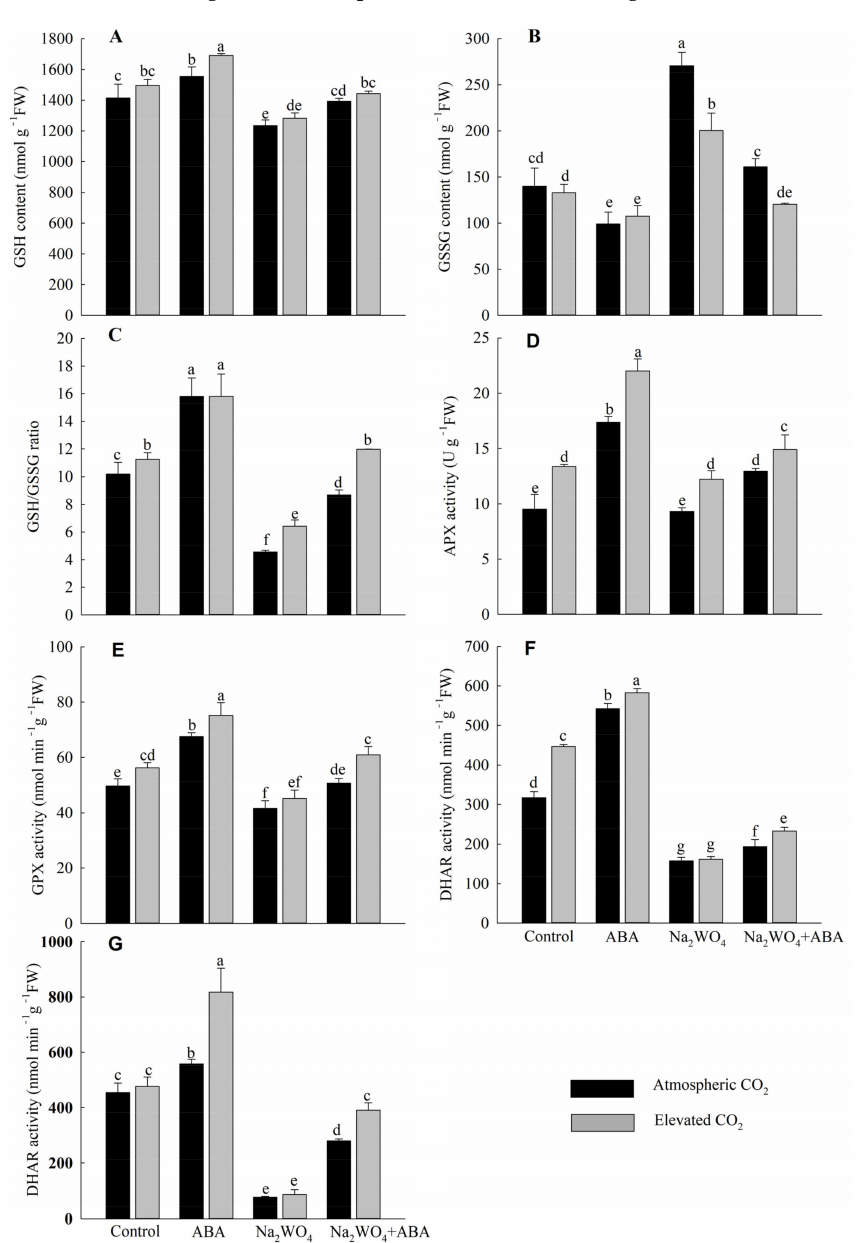
Figure 6. Effects of elevated CO 2 and exogenous ABA on GSH content ( A ), GSSG content ( B ), GSH/GSSG ratio ( C ), APX activity ( D ), GPX activity ( E ), DHAR activity ( F ), and GR activity ( G ) in leaves of cucumber seedlings under drought stress. Different lowercase letters represent significant differences between treatments at the 0.05 level. Values were the means ± SD (n =